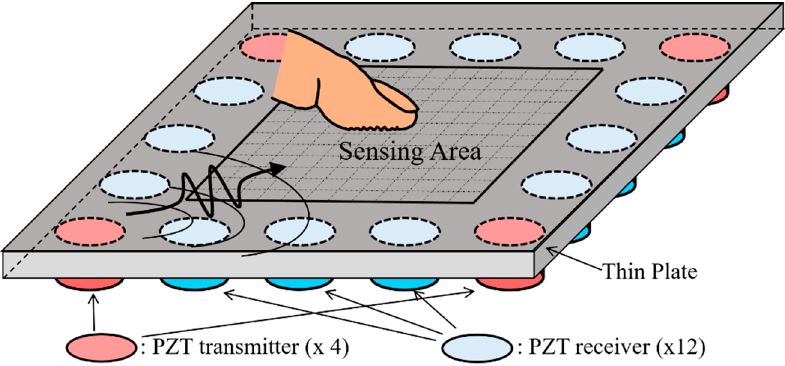
Figure 1. Schematic illustration of Lamb-wave-based ultrasonic touchscreen based on thin plate as touch panel and disk-shaped piezo-transducers as wave transmitters (four in present diagram) and receivers (twelve in present diagram). Tactile position sensing is conducted on upper surface of plate, while piezo-transducers are attached on under surface of plate.